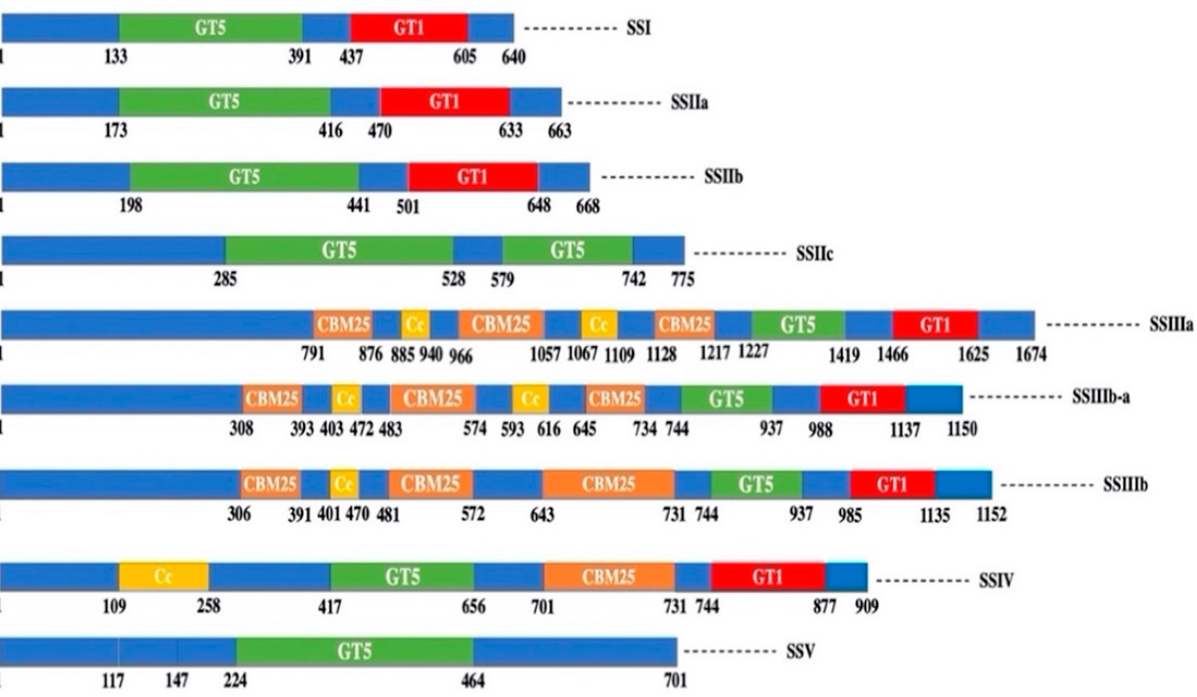
Figure 3. Domain structural features and active site of SS proteins. Zea mays SSs are shown as an example. The distribution and composition of domain structures are marked. The N terminus is on the left side of the figure and C terminus is on the right side. The glycosyltransferase family 1 (GT1) and glycosyltransferase family 5 (GT5) domains are shown in red and green colors, respectively. Conserved carbohydrate binding modules of family 25 (CBM25) are represented by orange coloration and coil coiled domains (Cc) are in yellow.